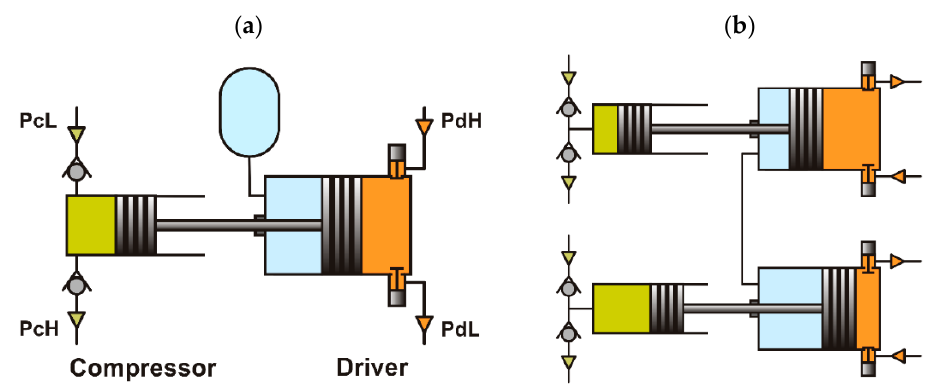
Figure 3. Modified single-acting schemes: with a receiver ( a ) and duplex scheme ( b ).